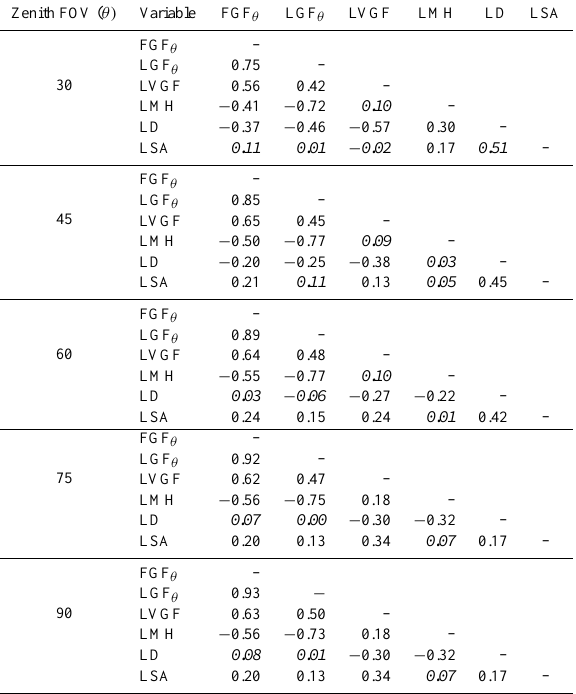
Table 5. Correlation matrix showing the coefficient of correlation ( r) between variables used in multiple regression (gap fraction only, for simplicity); non-significant ( p > 0 . 05) values shown in